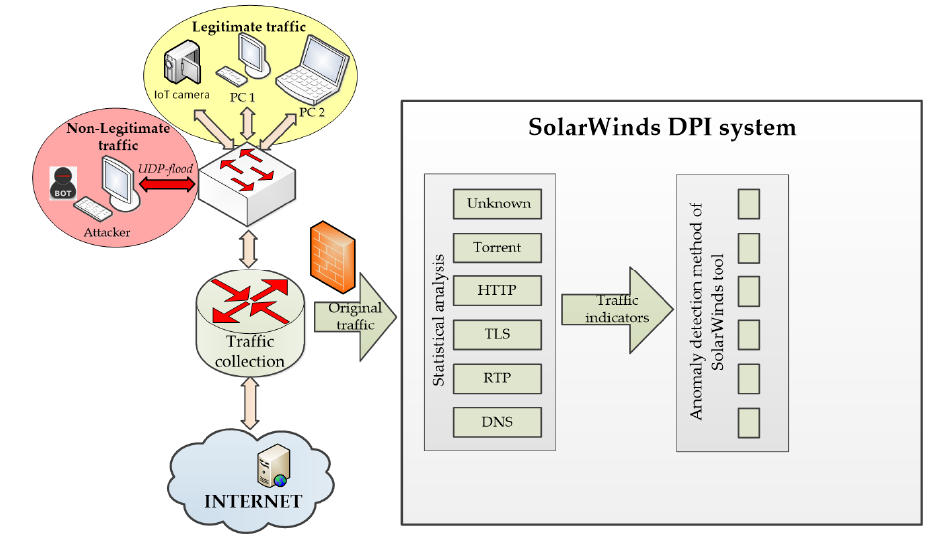
Figure 20. Network traffic analysis and anomaly detection scheme using the SolarWinds DPI system.